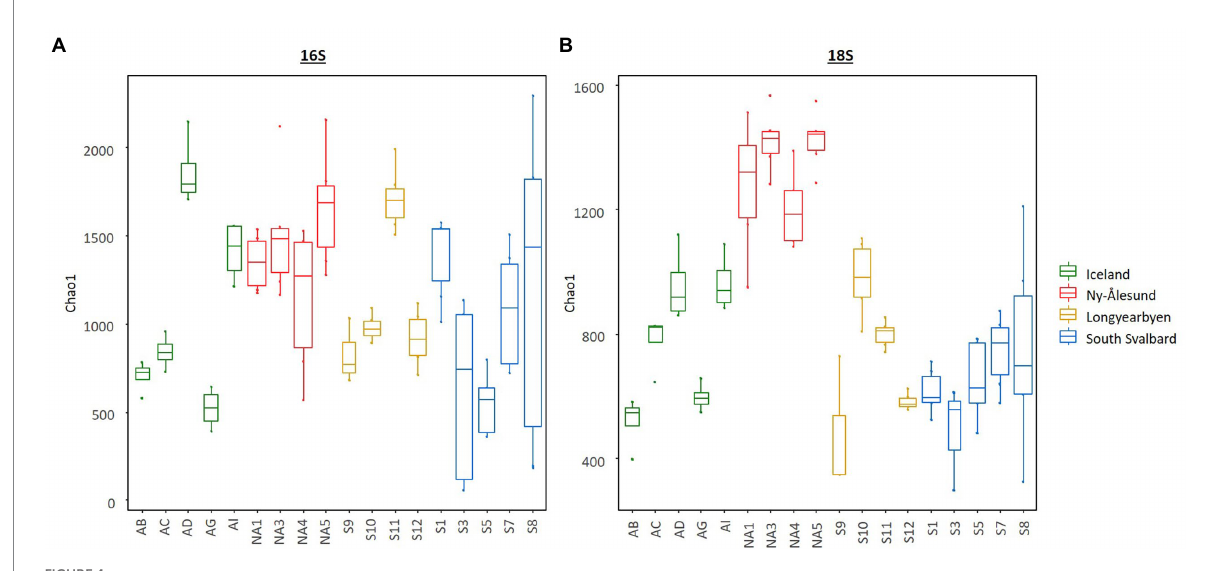
FIGURE 4 Box plots illustrating Chao1 diversity index in the biocrusts from the studied sites. (A) – bacteria and (B) – eukaryotes. Boxes represent the interquartile range and the horizontal line inside the box defines the